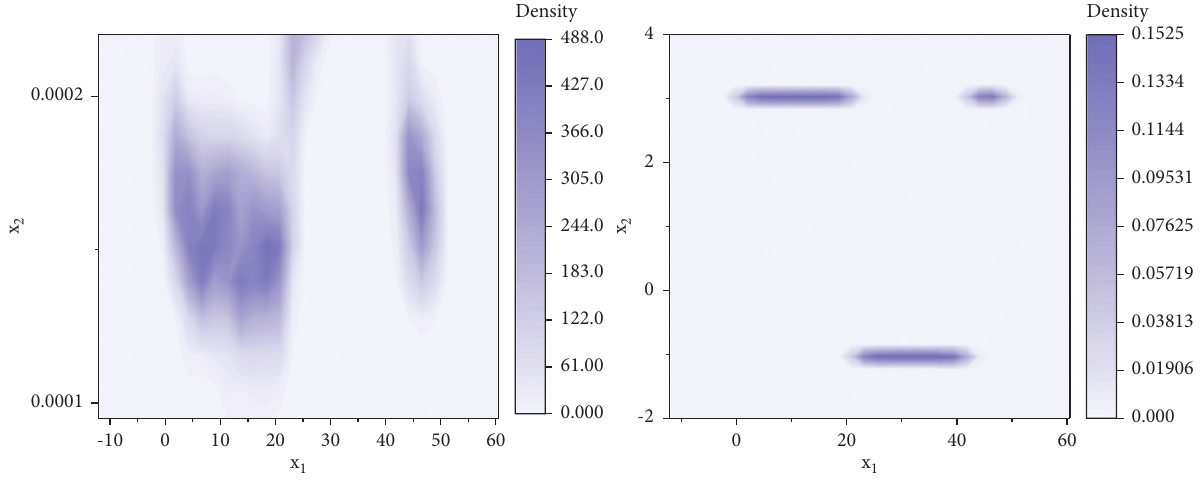
Figure 4: A set of attraction basins of the system with varying v .